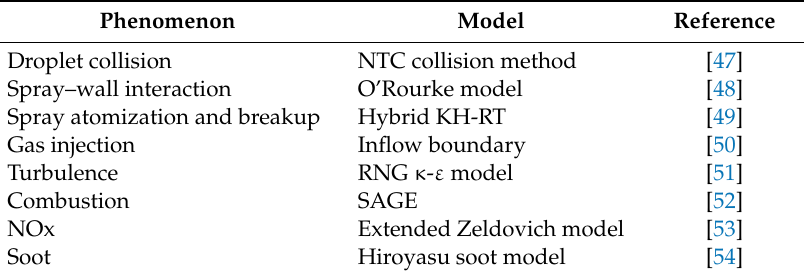
Table 2. List of submodels used in the